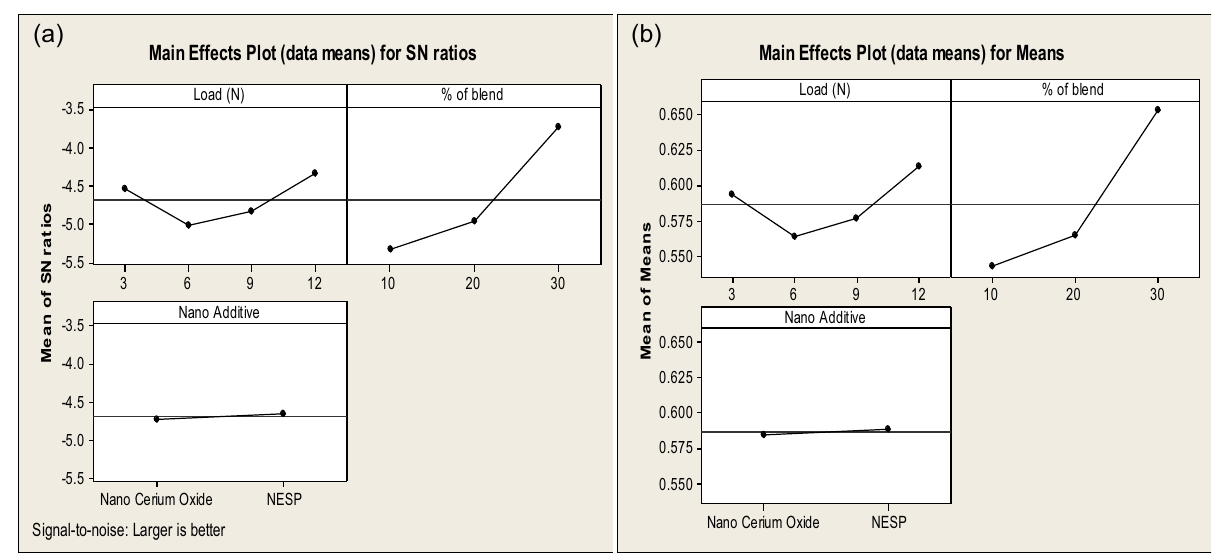
Fig. 5. (a) Main effect plot for the S/N ratio values of predicted GRG. (b) Main effect plot for the mean values of predicted